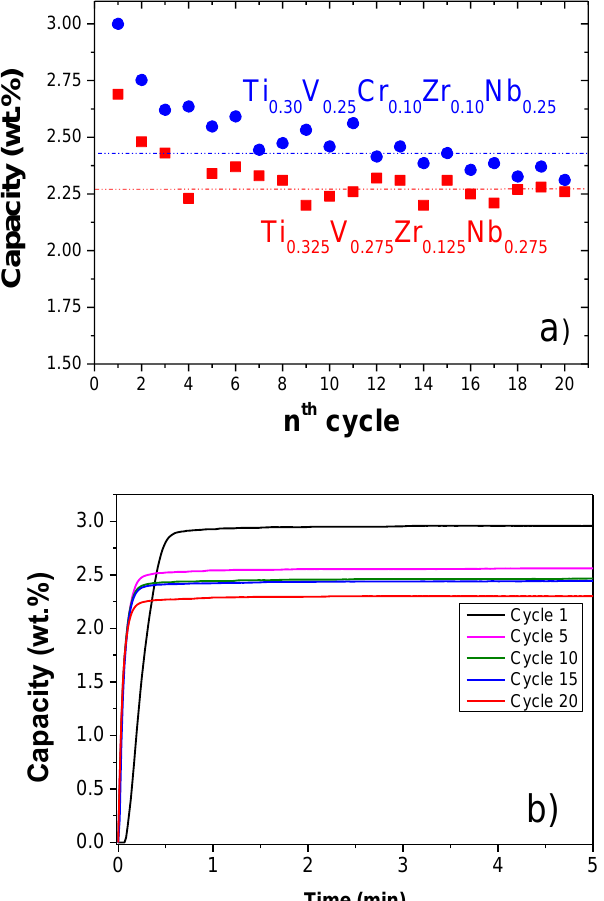
Figure 8. ( a ) Reversible hydrogen absorption capacity upon 20 absorption/desorption cycles for Ti 0.30 V 0.25 Cr 0.10 Zr 0.10 Nb 0.25 and Ti 0.325 V 0.275 Zr 0.125 Nb 0.275 alloys. ( b ) Kinetic curves during absorption of hydrogen under 50 bar at 25 °C for the Ti 0.30 V 0.25 Cr 0.10 Zr 0.10 Nb 0.25 alloy. The quinary Ti 0.30 V 0.25 Cr 0.10 Zr 0.10 Nb 0.25 alloy loses around 20% of the initial capacity